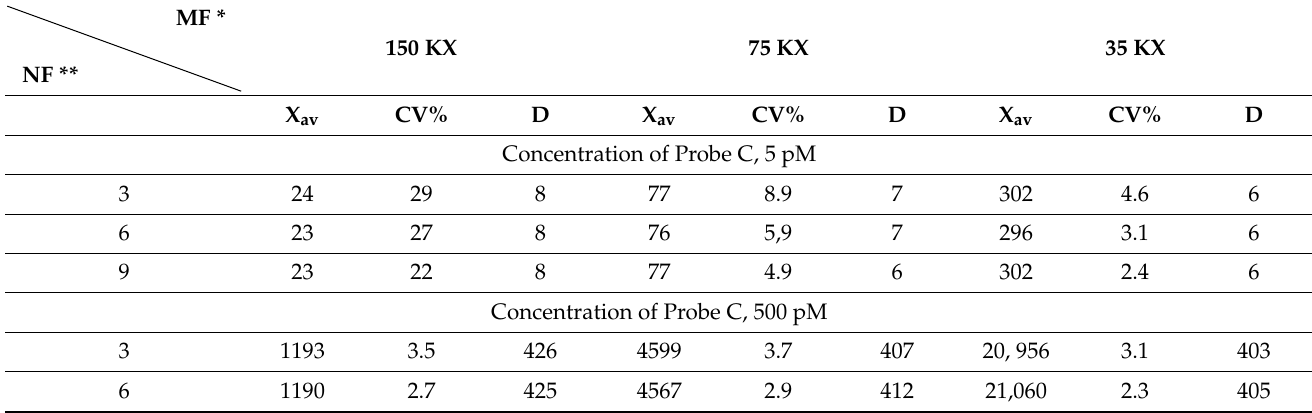
Table 2. Counting average GNP number (X av ), coefficients of variation (CV) and particle density (D) on separate frames of specific spots of the microchips by SEM at various microscope